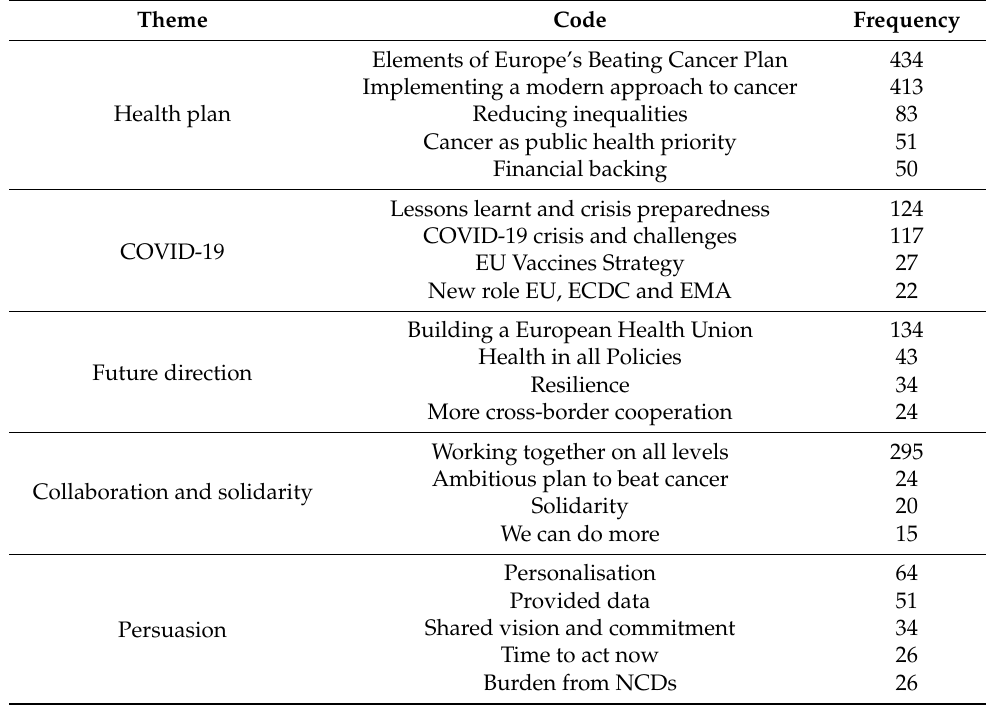
Table 1. Overview of themes, codes, and frequency of their